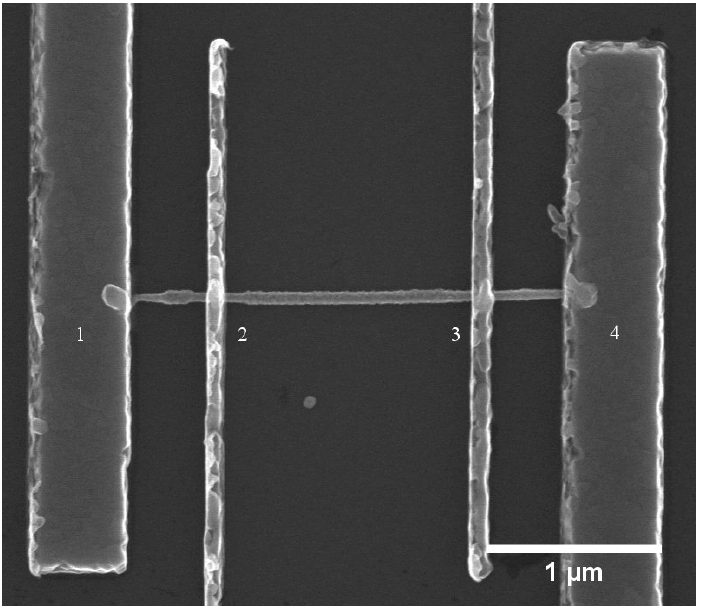
Figure 1. SEM image of a Zn doped GaAs nanowire with interdigitated metal electrodes. Four-probe resistivity and contact resistance measurements are carried out by passing a current through probes 1 and 4 while measuring the voltage difference between probes 2 and 3.